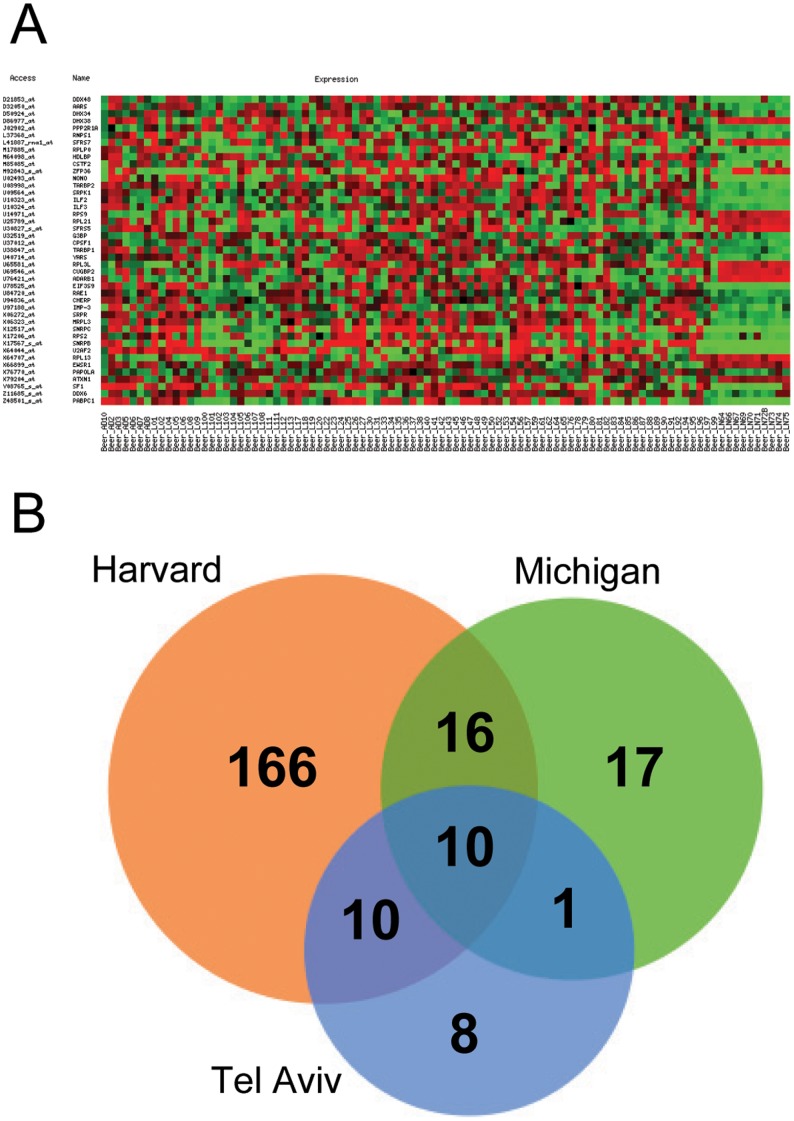
Gene selection by bioinformatics analysis. A) RNA-related genes with expression levels significantly different (p<0.01) between lung adenocarcinoma samples and normal lung samples (last 10 columns) in one of the microarray databases used in the study [23]. Red color denotes higher expression levels, whereas green color indicates lower expression levels. B) Venn diagram corresponding to genes with significant expression differences between normal and adenocarcinoma samples.